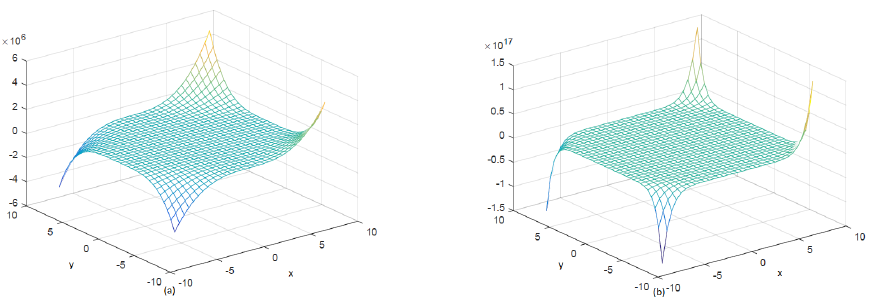
Figure 9: Plotting of (a) M-polynomial and (b) NM-polynomial of convolutamy- dine